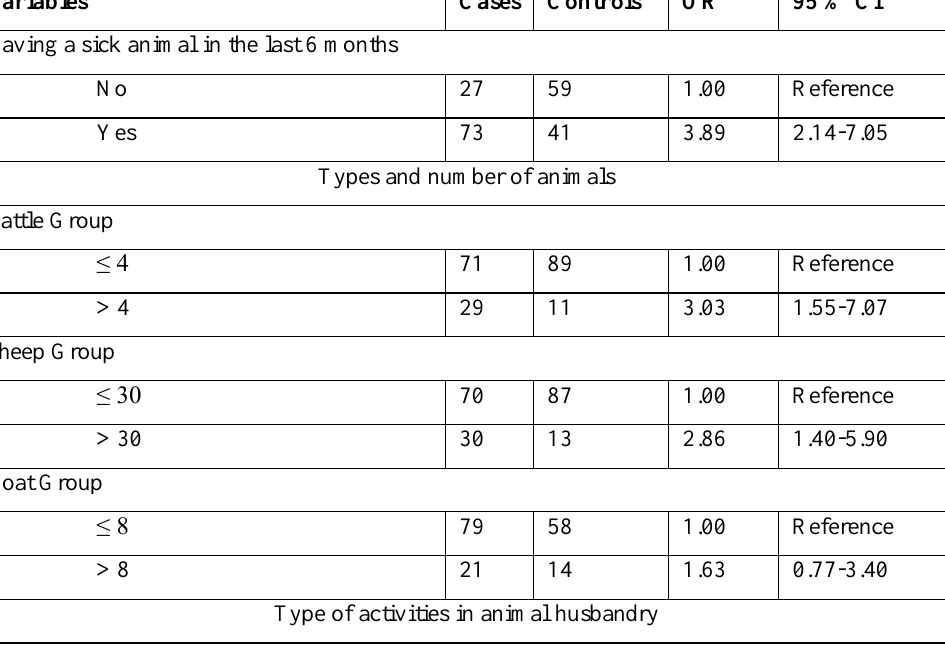
Table 3: Statistical analysis of behavioral risk factors associated with Brucellosis and Q fever in Bamyan Province in July 2011